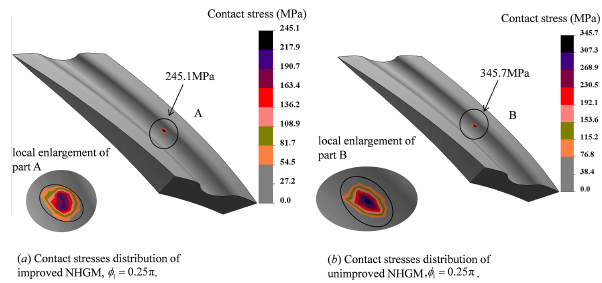
Figure 9. l a and l b of the contact ellipses of the improved and unim- proved NHGM.